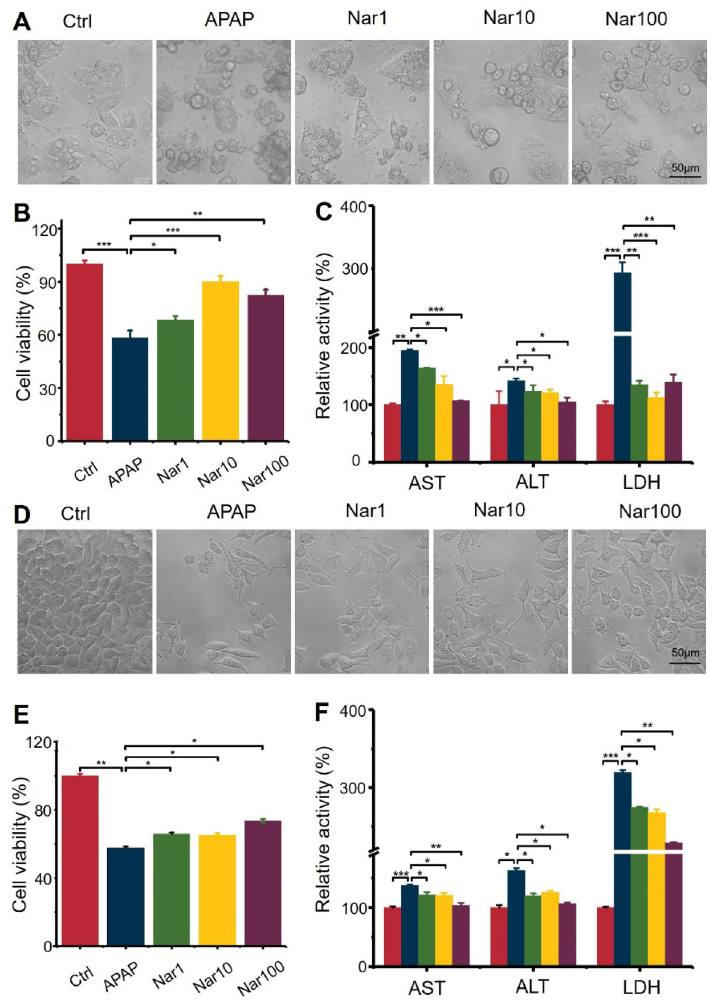
Figure 1. Cells pretreated with different concentrations of naringin (Nar) (1, 10, or 100 m M) for 8 h were exposed to acetaminophen (APAP; 20 mM) for 24 h. A and D , Cell morphology of the different groups, as assessed by microscopy (scale bar 50 m m). B and E , A CCK8 assay was used to determine the survival rate of primary rat hepatocytes and HepG2 cells. C and F , Aspartate aminotransferase (AST), alanine aminotransferase (ALT), and lactate dehydrogenase (LDH) levels were measured by ELISA to assess cell damage. Data are reported as means ± SD (n=3). *P o 0.05, **P o 0.01, and ***P o 0.001 vs the APAP group